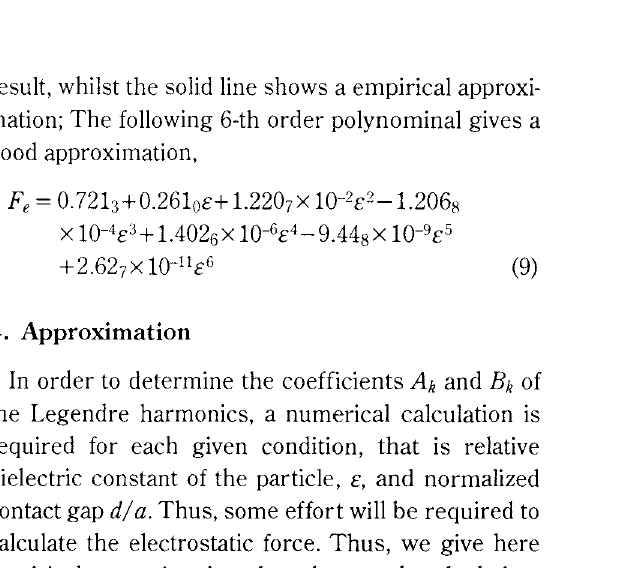
The electrostatic force as a function of the normalized contact gap